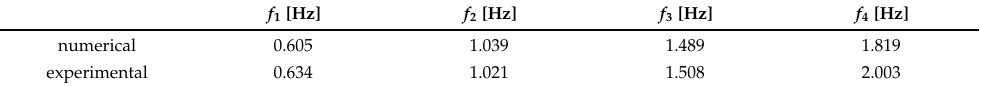
Table 3. ‘Ponte delle Torri’: numerical and experimental first four natural frequencies f i .